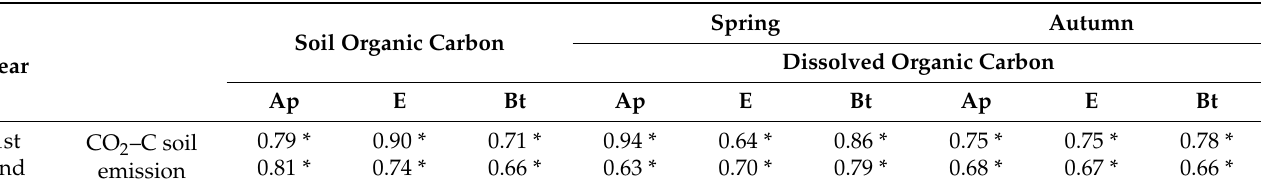
Table 4. Correlation coefficients describing the relationship between the cumulative CO 2 –C soil